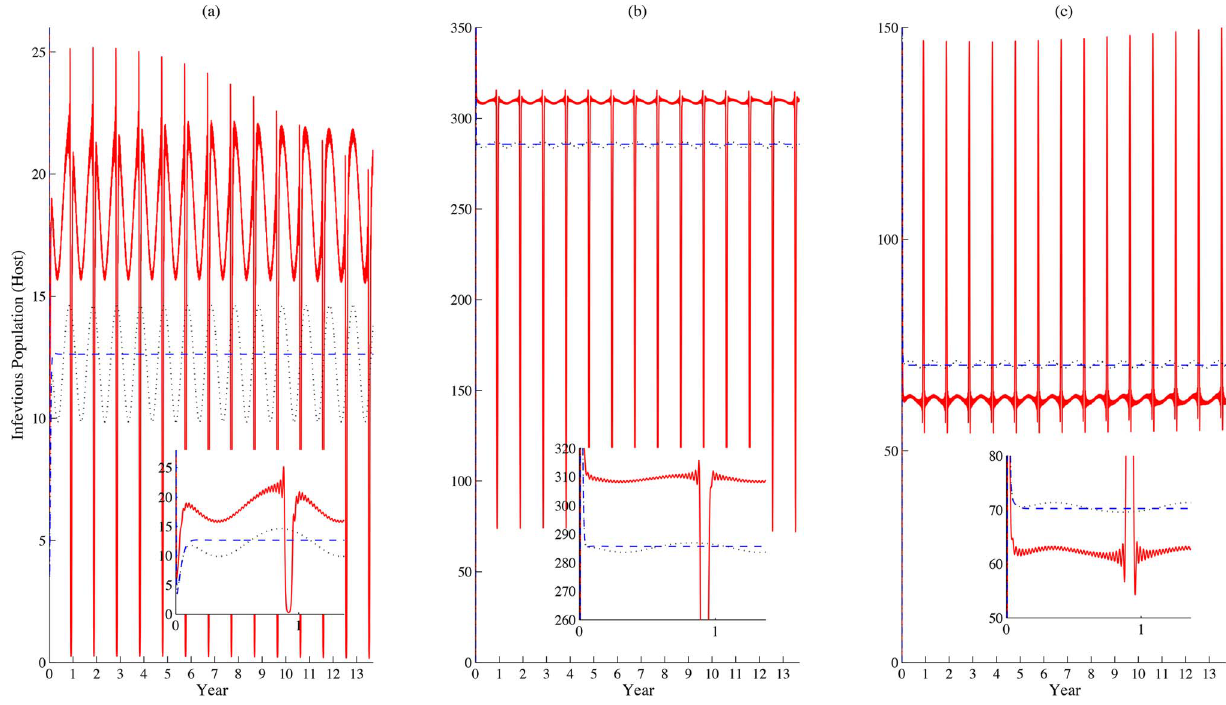
Fig. 3. Model comparison. (a), (b) and (c) show the populations of infectious livestock in patches 1, 2 and 3, respectively. The dashed, dotted, and solid lines represent three scenarios with 1) no periodic factors; 2) only the capacity of mosquitoes is periodic; and 3) parameters incorporating both seasonal and festival impacts. Values of parameters: a 1 ~ a 2 ~ a 3 ~ 3 | 10 { 3 , b 1 ~ b 2 ~ b 3 ~ 8 | 10 { 3 , E 1 ~ E 2 ~ E 3 ~ 0 : 6, m ~ 1 : 2 | 10 { 3 , f ~ 5 | 10 { 3 , d 1 ~ 100, d 2 ~ 800, j 1 ~ j 2 ~ j 3 ~ 0 : 1, g 1 ~ g 2 ~ g 3 ~ 0 : 5, c ~ 0 : 4, d ~ 0 : 1, n ~ m ~ 10, n 1 ~ n 2 ~ n 3 ~ 0 : 06, b 1 ~ 0 : 3, dc ~ dc ’ ~ 98, dr ~ dr ’ ~ 20, d (cid:2) mm ~ d (cid:2) mm 0 ~ 0 : 02 : Initial conditions: S 1 ~ 1800, E 1 ~ 0, I 1 ~ 50, R 1 ~ 100, U 1 ~ 1000, L 1 ~ 0, V 1 ~ 0, S 2 ~ S 3 ~ E 1 ~ E 2 ~ I 2 ~ I 3 ~ R 2 ~ R 3